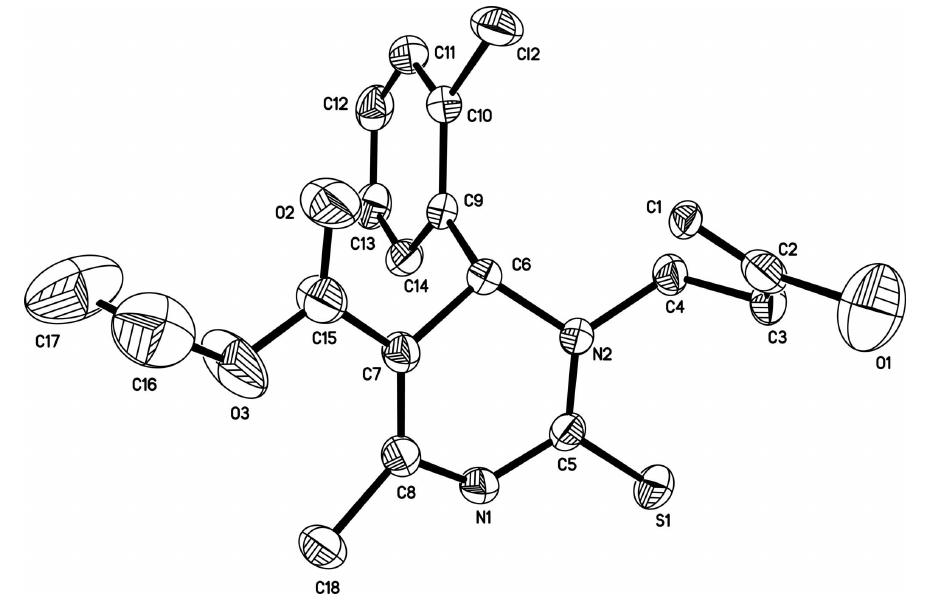
The molecular structure of (I) showing the atomic numbering and 30% probability displacement ellipsoids. Only major parts of disordered atoms is shown. H atoms omitted for